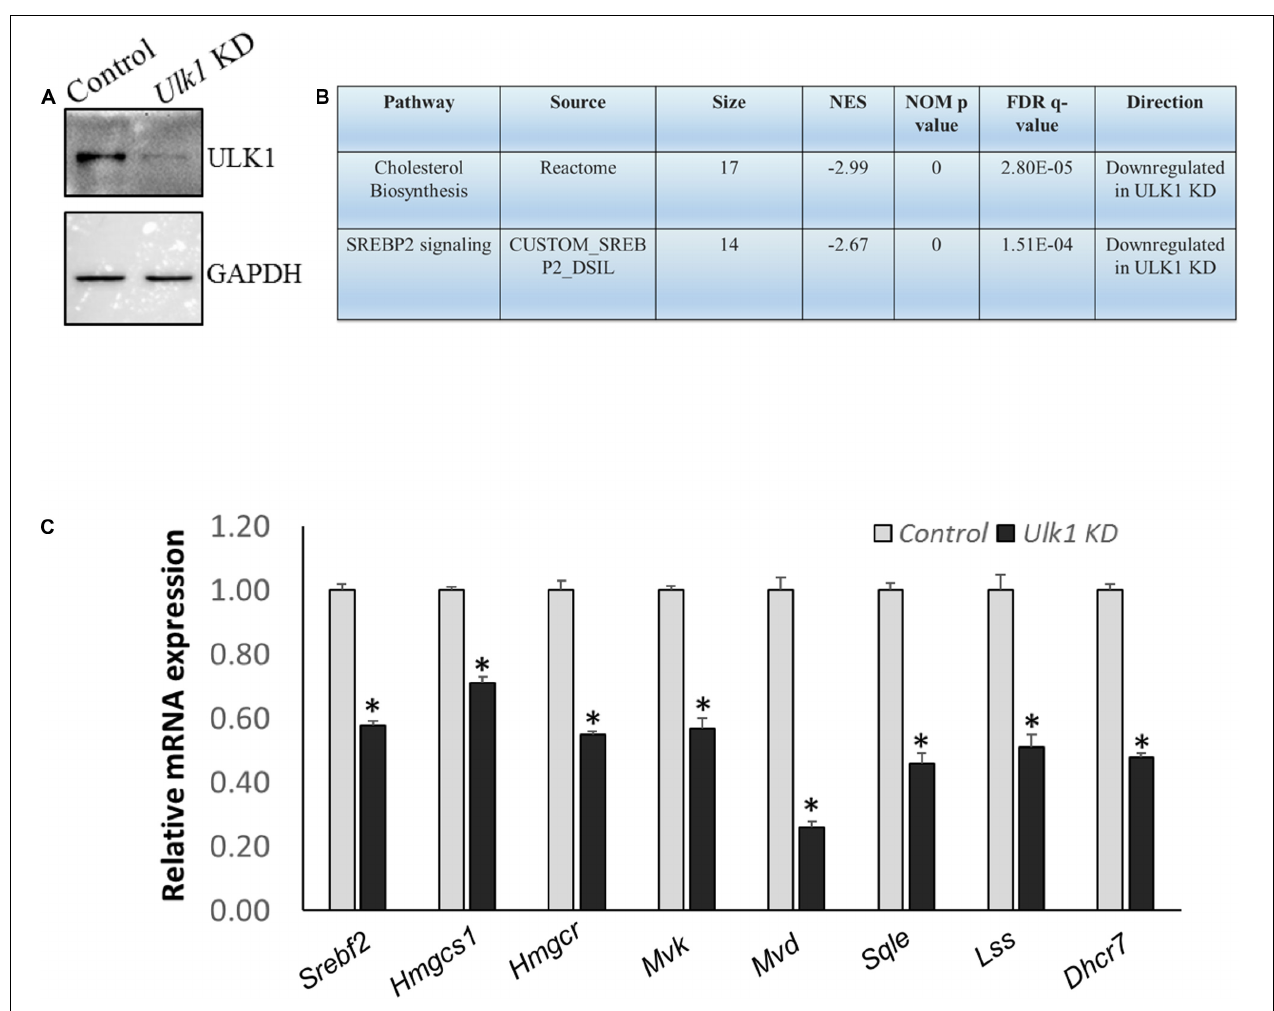
FIGURE 3 | ULK1 loss suppresses the expression of human cholesterogenic genes (A,B) Representative immunoblot showing KD efficiency of ULK1 and RNA-seq derived transcriptomic pathway analysis in HepG2 cells treated with ± Ulk1 siRNA (Thermo Fisher Scientific, s15965; 10 nM/72 h). (C) qRT-PCR validation